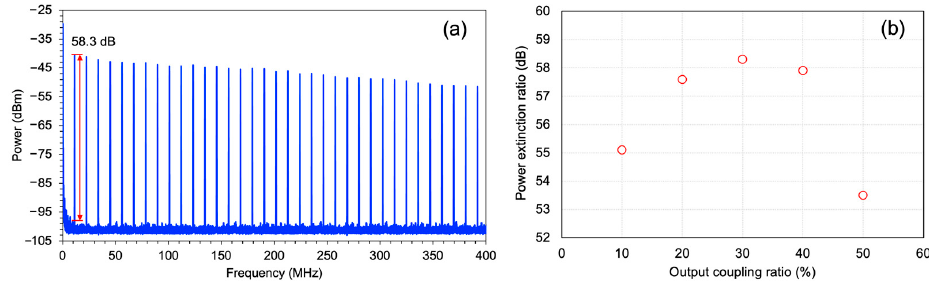
Figure 10. ( a ) RF spectrum using the 30% output coupling ratio and ( b ) the PER value at the funda- mental frequency for di ff erent output coupling ratio values using 99 mW pump power.